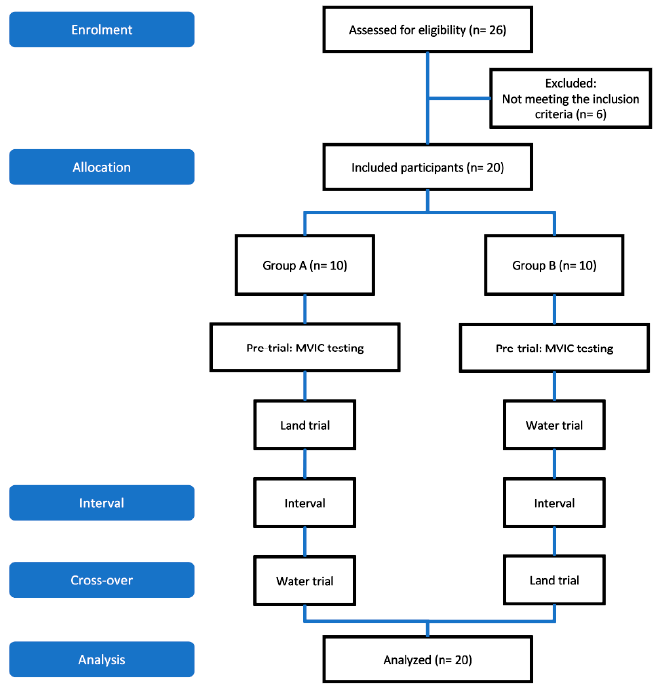
Figure 1. Study flow chart.